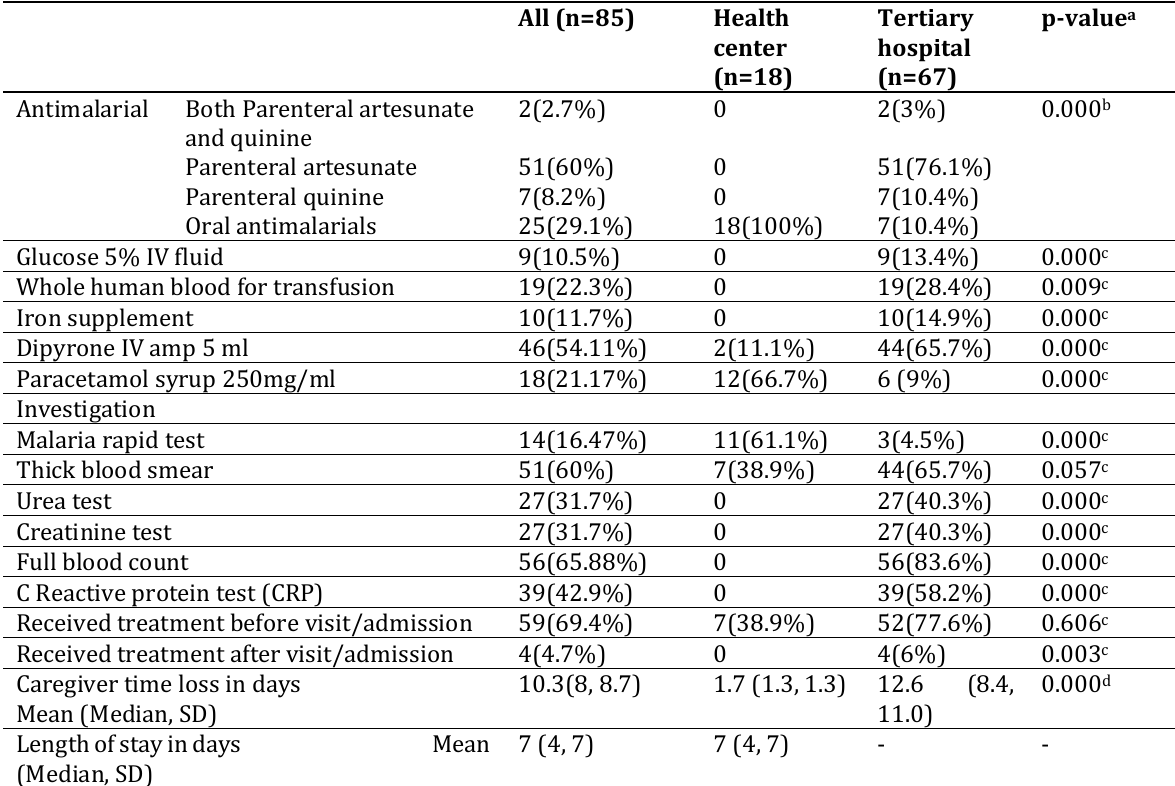
Table 2: Major ressources